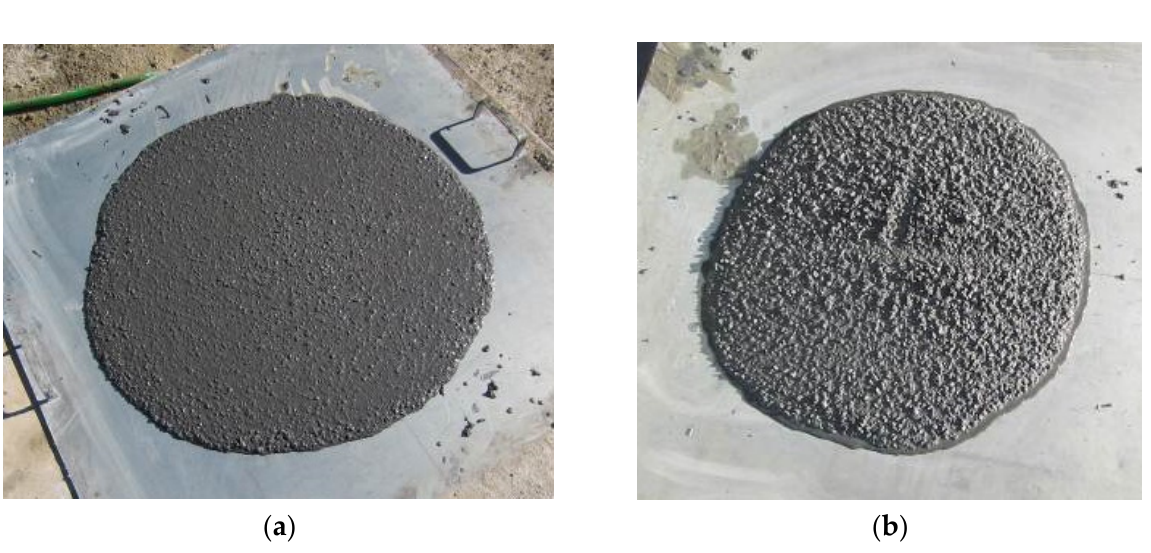
Figure 8. Slump-flow tests from ( a ) test 6 and ( b ) test 8 high-strength self-compacting concrete production.